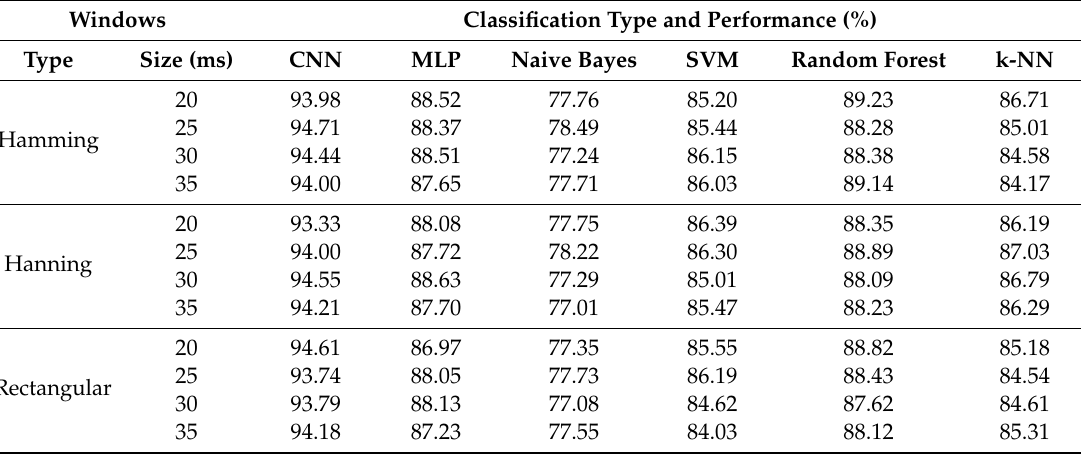
Table 5. Performance accuracy for male speakers based on GRU + EZDMFCC.